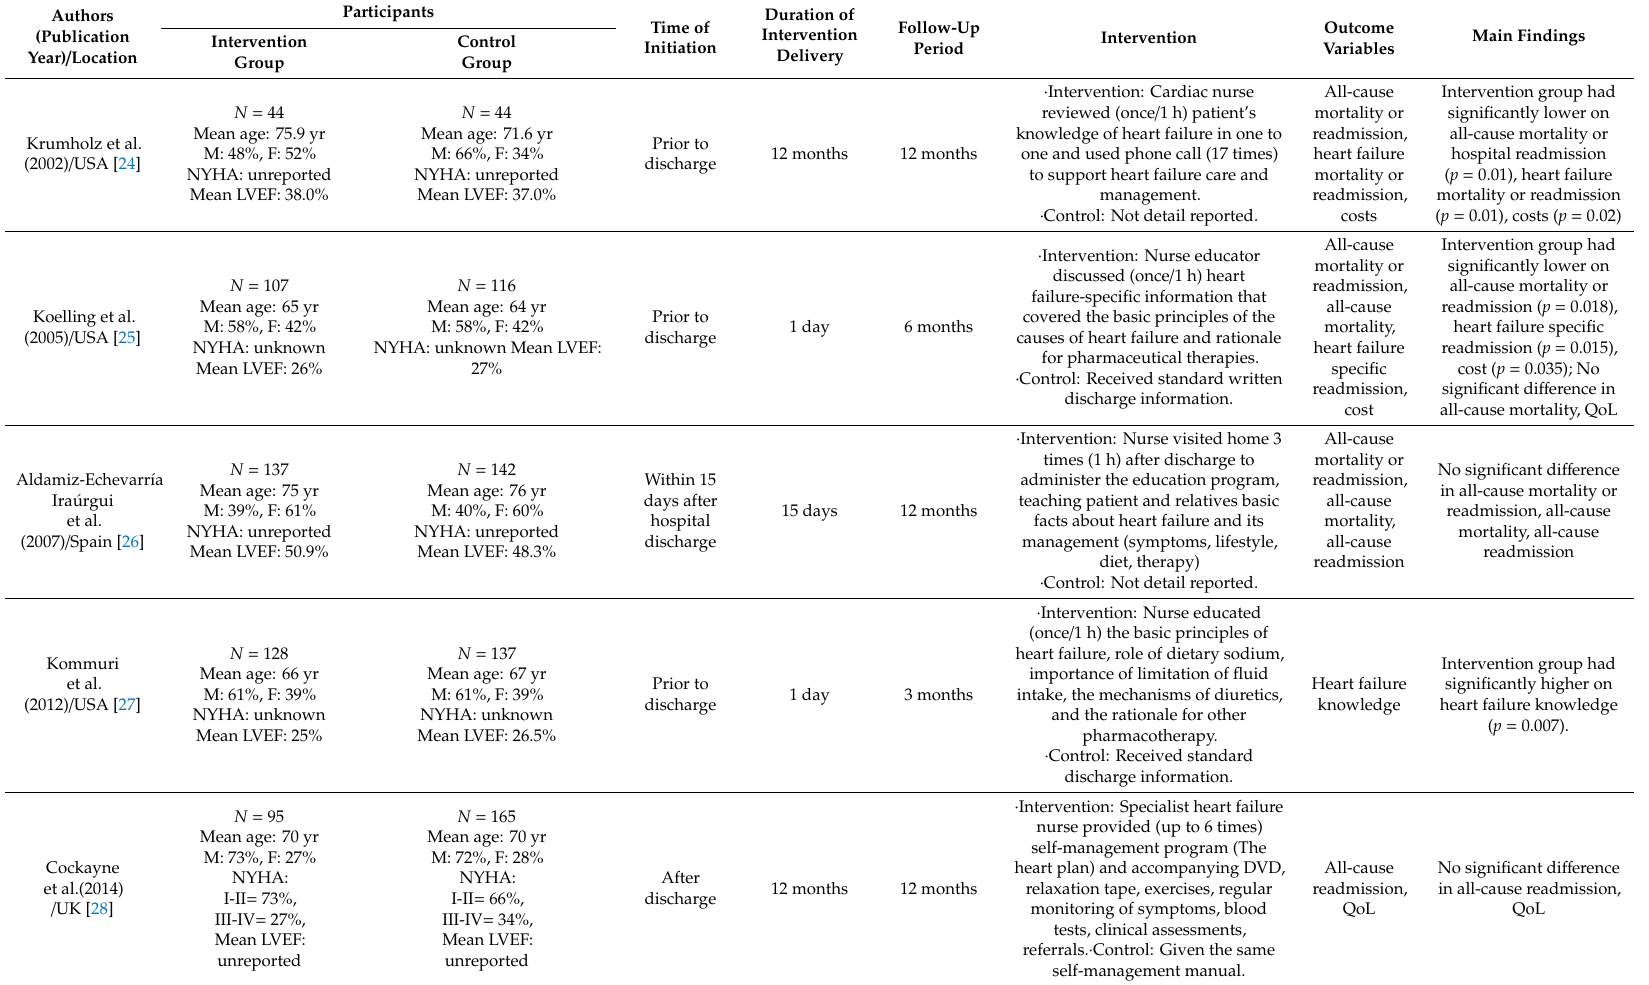
Table 1. Description of studies included ( N =